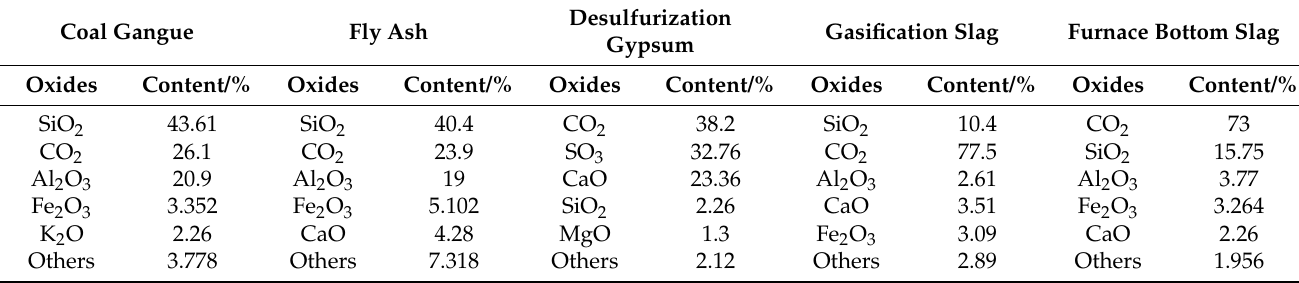
Figure 2. Particle size distribution of three solid wastes. Table 1. XRF results of solid waste Table 1. XRF results of solid waste materials.